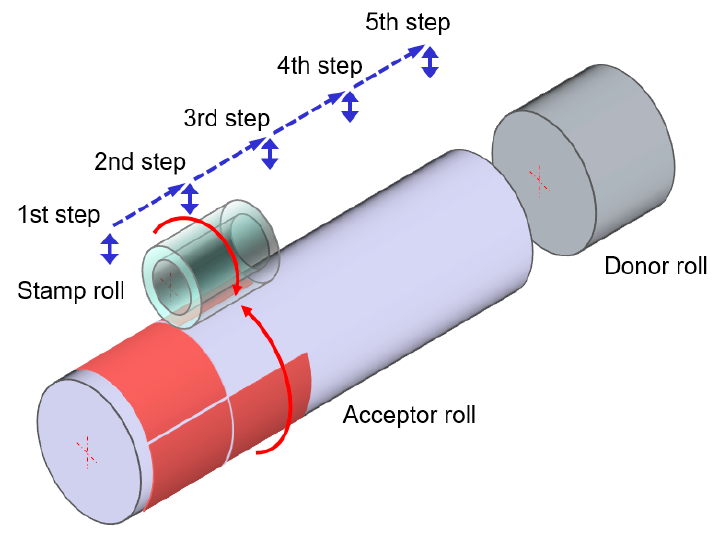
Figure 2. Step-and-repeat manner in the longitudinal direction of the proposed process.